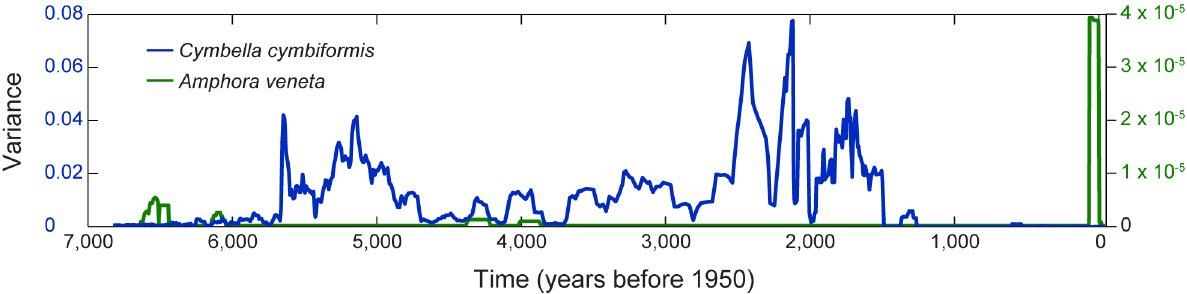
Figure 2. The variance of two diatom species. While Cymbella cymbiformis displayed a pattern of increasing variance prior to , 1.3 ka, Amphora veneta did not. Conflicting patterns make it difficult to use univariate statistics to characterize the behavior of a complex multivariate system.